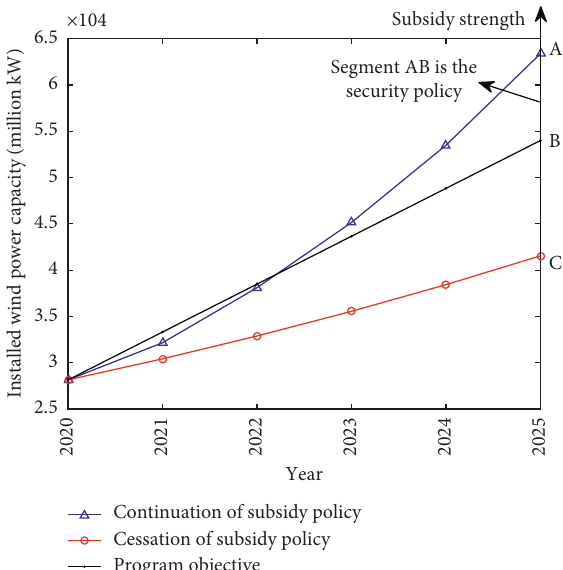
Figure 8: Quantitative analysis of the subsidy strength for the wind power installed